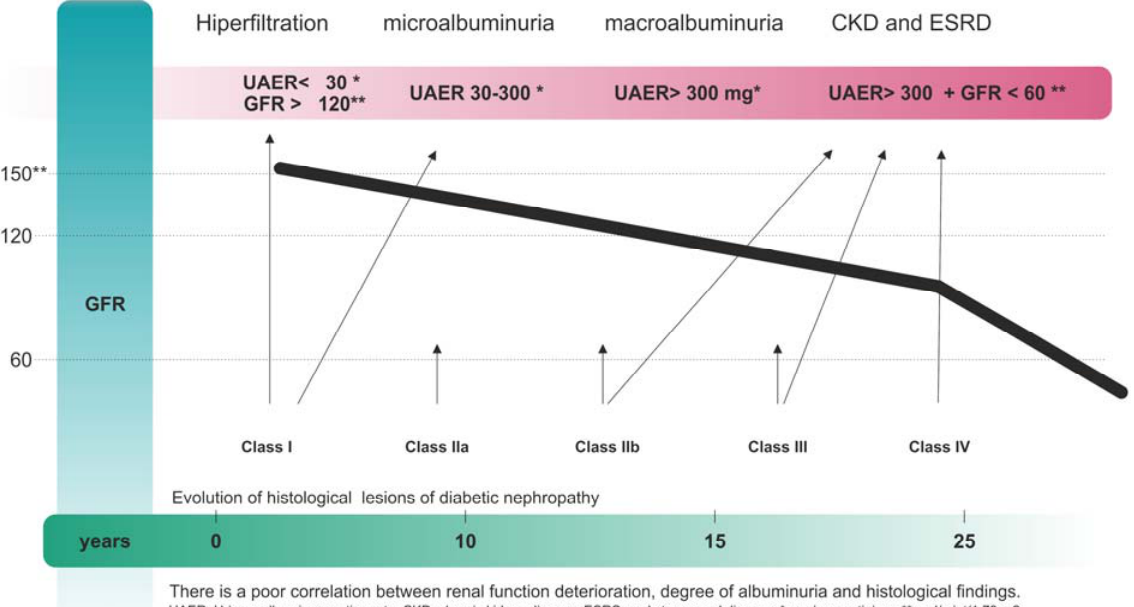
Figure 1. Natural history of diabetic nephropathy. There is a poor correlation between renal function deterioration, degree of albuminuria and histological findings. UAER: Urinary albumin excretion rate; CKD: chronic kidney disease; ESRS: end stage renal disease; * mg/gr creatinine; ** mL/mint/1.73 m 2